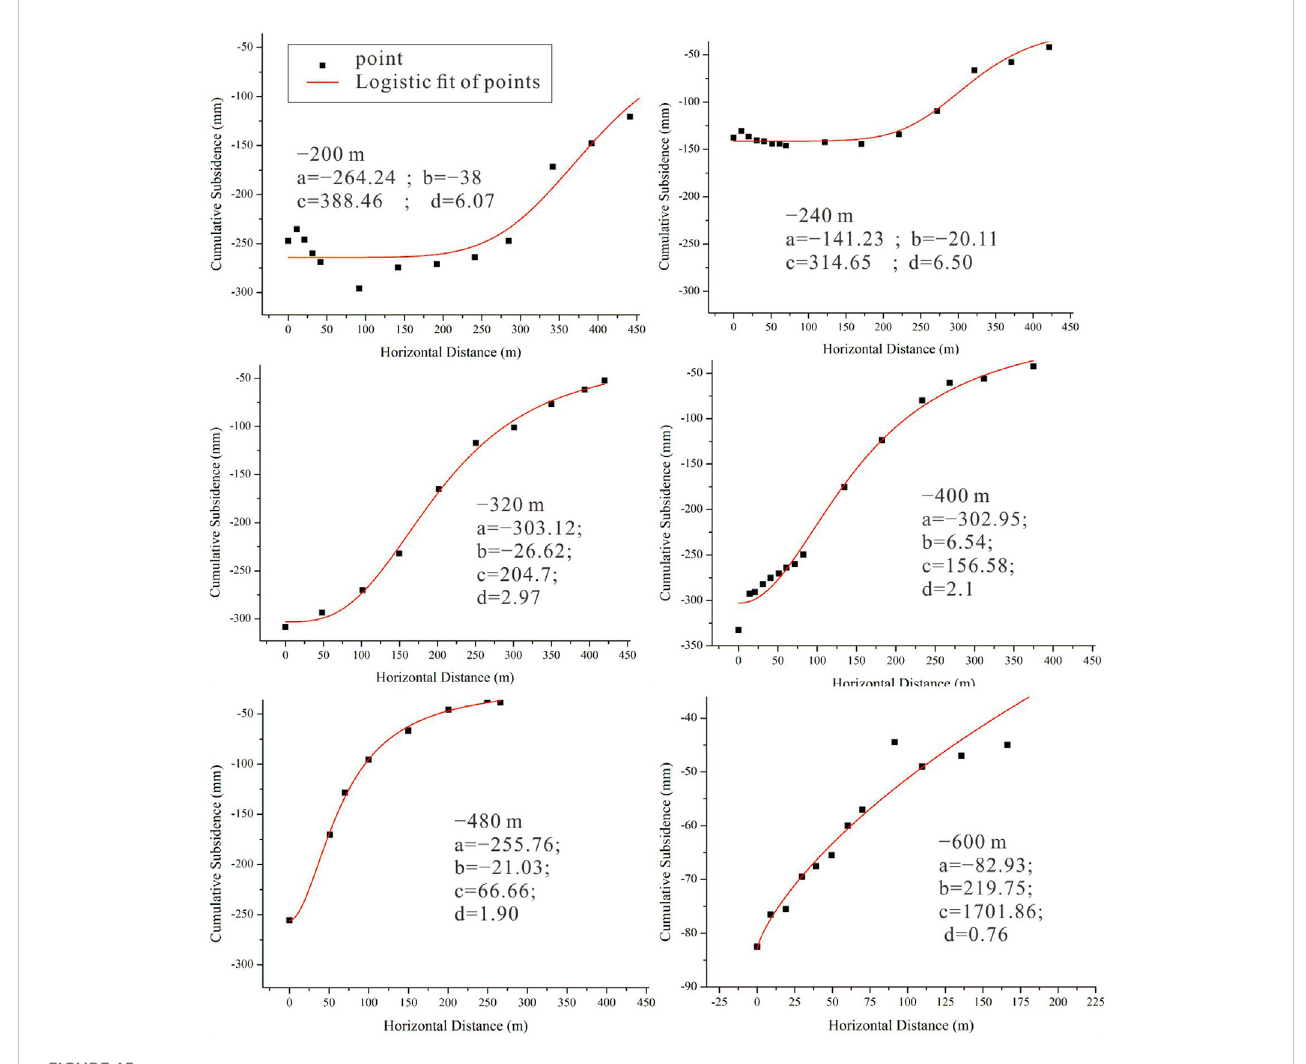
FIGURE 15 Logistic fi tting results and relevant parameters in the